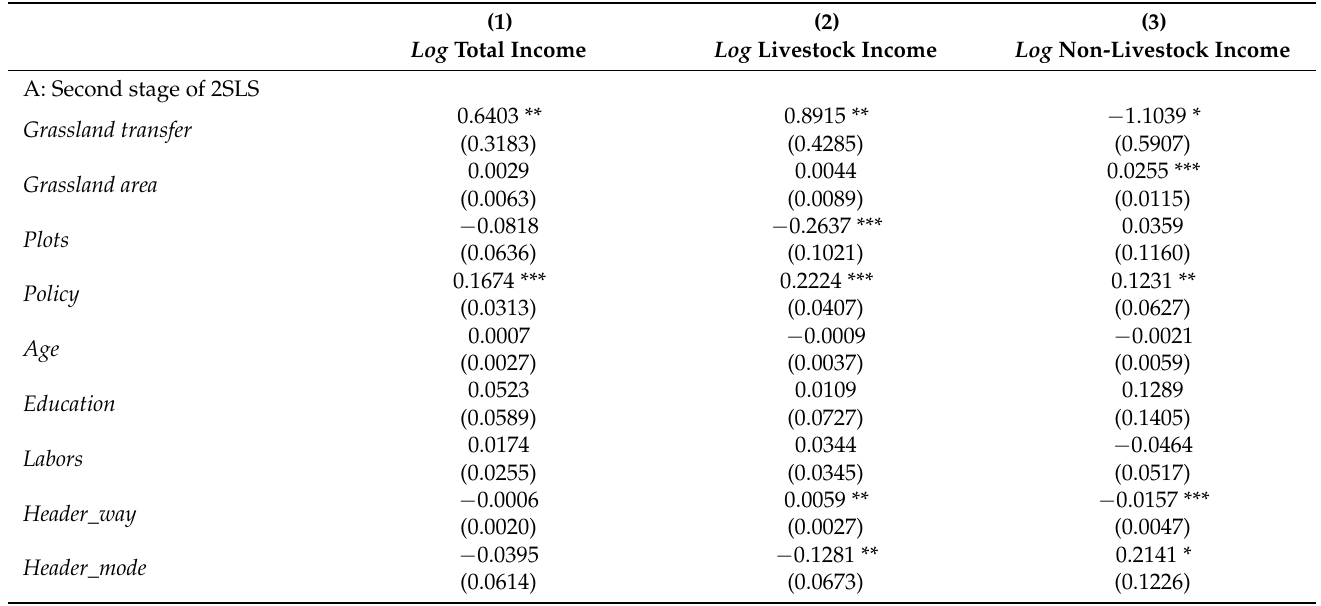
Table 4. Robustness test of instrumental variable